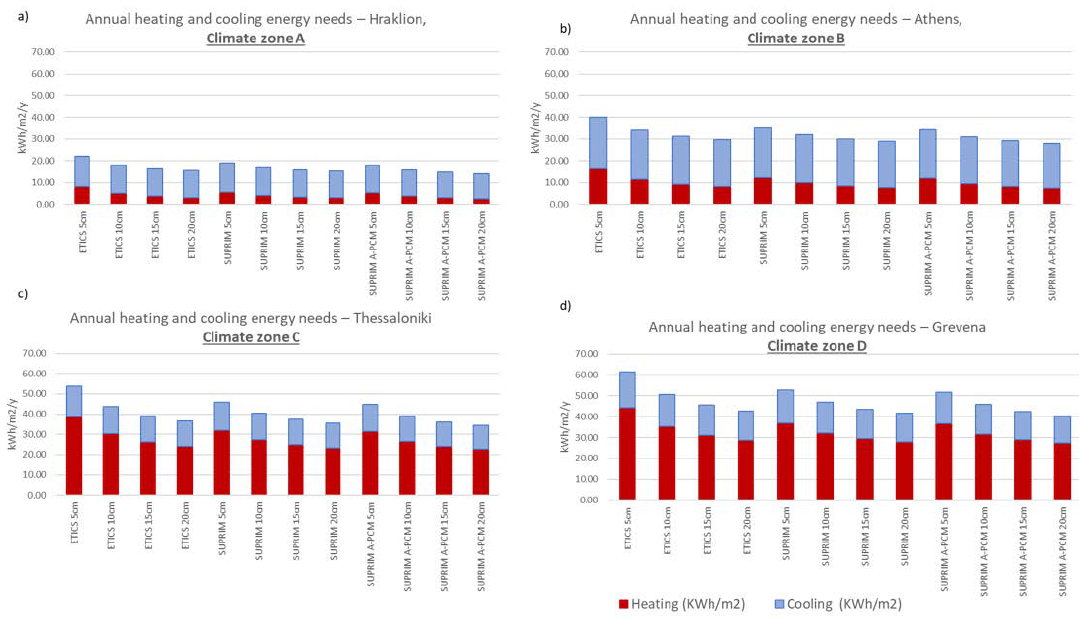
Figure 5. The heating and cooling needs calculated for the three examined construction types (conventional with exterior insulation, sustainable preconstructed innovative module (SUPRIM) and SUPRIM-PCM) for climate zone A, B, C, and